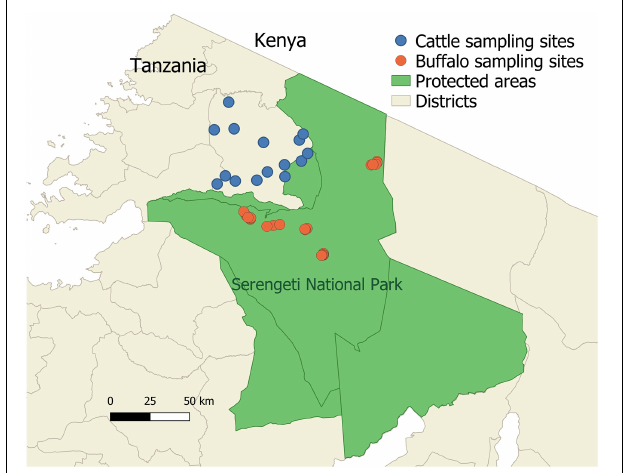
FIGURE 1 | The study area showing locations of cattle and buffalo sampling in the Serengeti-Mara ecosystem. Cattle sampling sites are shown in blue and buffalo sampling sites are shown in orange. Cattle sampling sites (villages) were selected from those close to the protected area boundaries in Serengeti District. Protected wildlife areas are shown in